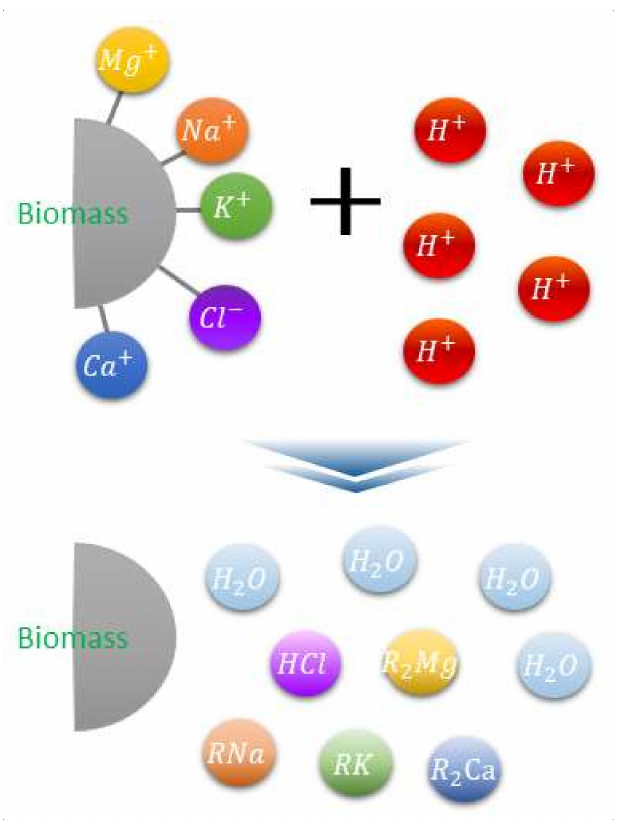
Figure 2. Biomass ash elimination mechanism involving acid treatment